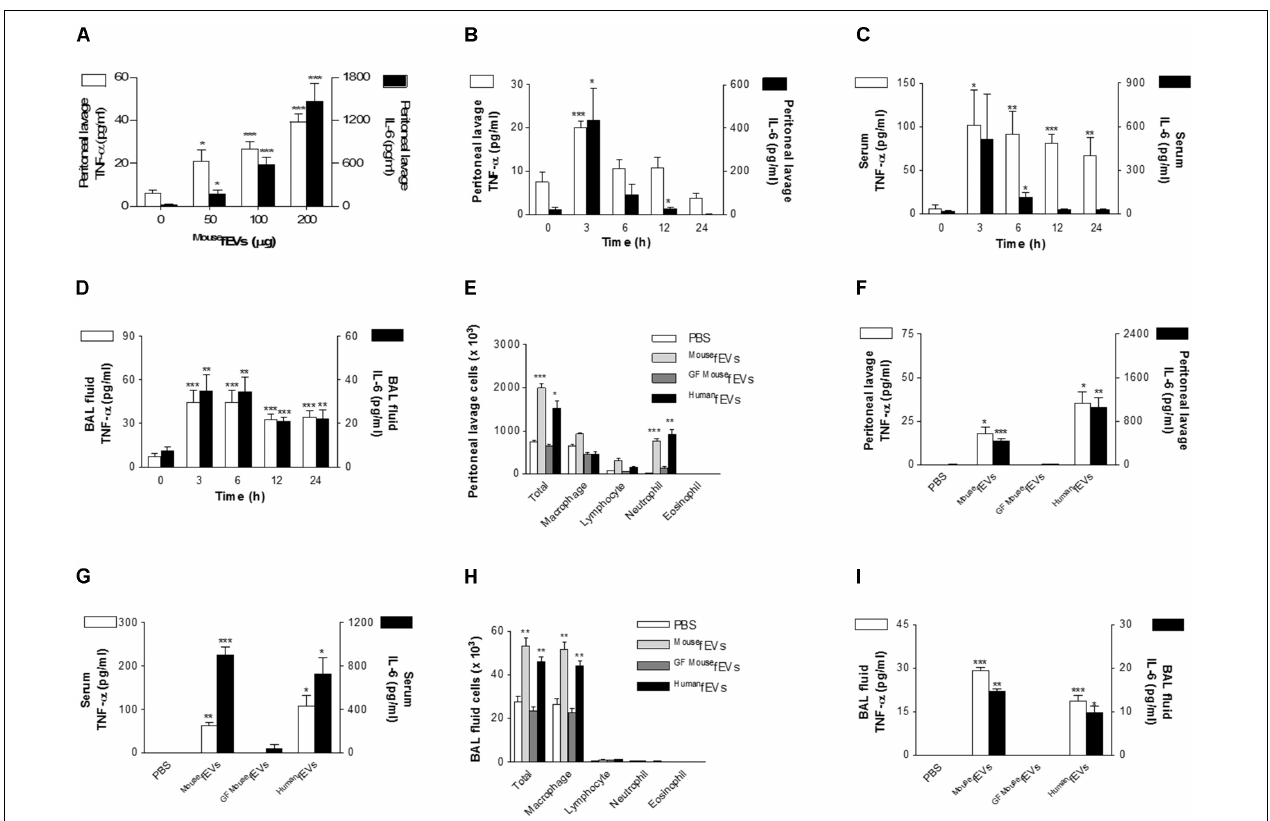
FIGURE 3 | Comparison of peritoneal, systemic, and pulmonary inflammation by Mouse fEVs, GFMouse fEVs, and Human fEVs. (A) Dose-dependent effects of Mouse fEV-induced increase of the release of TNF- α and IL-6 in the peritoneal lavage fluid, after intraperitoneal introduction of Mouse fEVs ( n = 5). (B–D) The time course of Mouse fEV-induced increase of the release of TNF- α and IL-6 in the peritoneal lavage fluid (B) , serum (C) , and BAL fluid (D) , after intraperitoneal introduction of Mouse fEVs (100 µ g in total protein amounts; n = 5). (E–I) At 3 h after intraperitoneal introduction of Mouse fEVs, GFMouse fEVs, or Human fEVs (100 µ g in total protein amounts; n = 5 for PBS and Mouse fEVs group, n = 3 for GFMouse fEVs group, and n = 5 for Human fEVs group), the number of inflammatory cells (E) , and the concentration of TNF- α and IL-6 in the peritoneal lavage fluid (F) were quantified. The concentration of TNF- α and IL-6 in the serum (G) , the number of inflammatory cells (H) , and the concentration of TNF- α and IL-6 in the BAL fluid (I) were also measured. ∗ P < 0.05, ∗∗ P < 0.01, and ∗∗∗ P < 0.001, respectively, when the data were compared to 0 h or PBS group. Error bars indicate